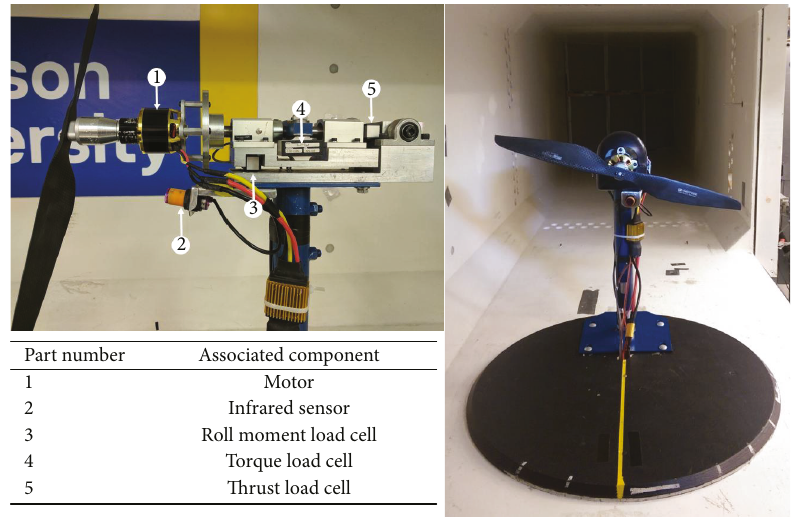
Figure 3: Rotor test stand and test setup in the wind-tunnel test